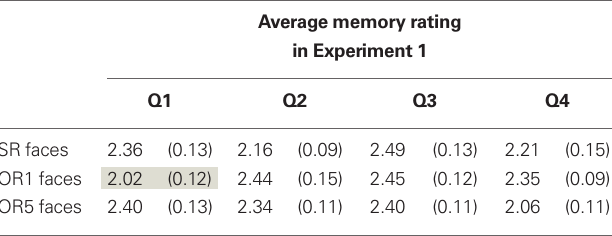
Table 3 | Recognition accuracy for faces in Experiment 1 as a function of consensus ratings of race-typicality in Experiment